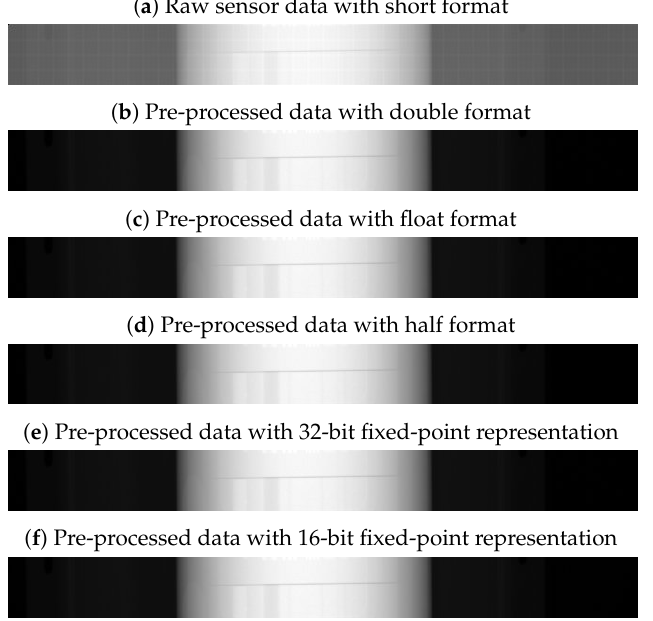
Figure 15. Single projection of module CTP401, before and after the pre-processing.